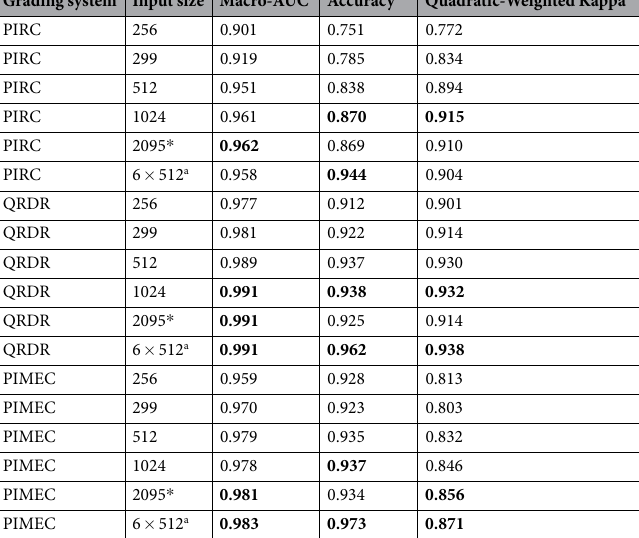
Table 3. Classification results for PIRC, QRDR and PIMEC with varying input image sizes on the primary validation set. Macro-AUC refers to area under macro average of ROC for each class one-vs-all manner. * Trained with model using instance normalization layers and an optimizer with accumulation of 15 mini- batches. a Ensemble of six classifiers trained on same data with same input